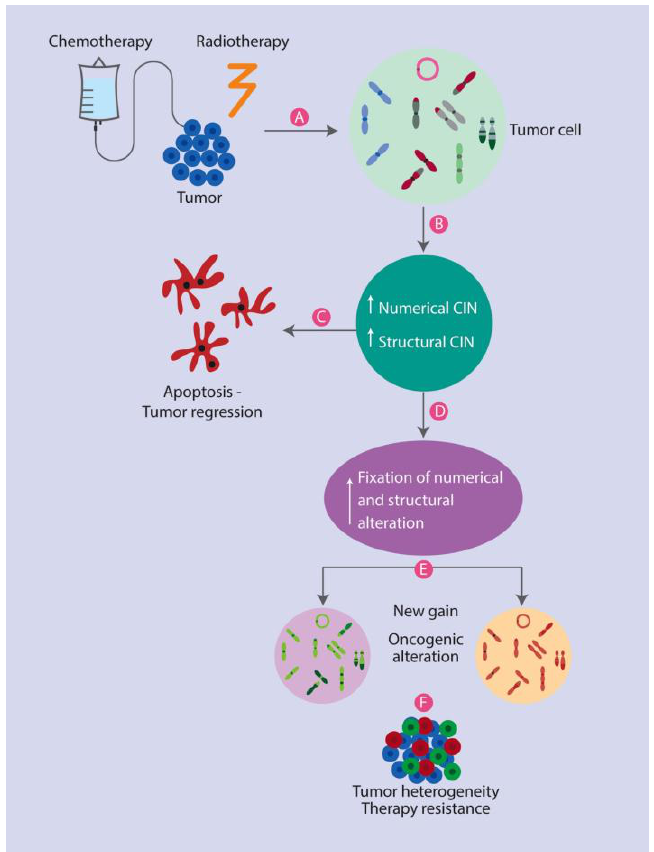
Figure 4. CIN Positive or Negative Response to Treatment. ( A ) The administration of chemotherapy or radiotherapy to tumor cells ( B ) can lead to the induction of new numerical and structural chromosomal alterations; This condition could generate two cellular responses; ( C ) one of them related to the induction of apoptosis (probably due to the excess of genotoxicity), improving the prognosis for the patient by tumor regression, and the other ( D ) related to the fixation of numerical and structural alterations; ( E ) consequently leading to clonal expansion of new oncogenic alterations and thus ( F ) to an overall increase in heterogeneity and development of resistance to therapy.